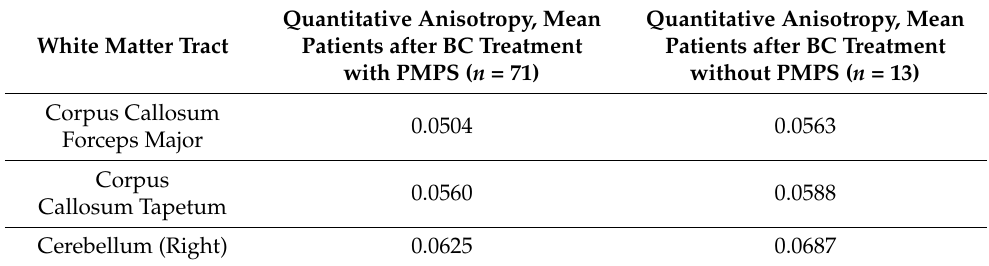
Figure 3. Three-dimensional reconstruction of the white matter tracts with the signs of a decrease in quantitative anisotropy in patients after BC treatment with the presence of vestibulocerebellar ataxia in comparison with patients after BC treatment without vestibulocerebellar ataxia (( a )—axial plane, ( b )—coronal plane). Table 5. White matter tracts with lower quantitative anisotropy in patients after BC treatment with the presence of PMPS in comparison with patients after BC treatment without